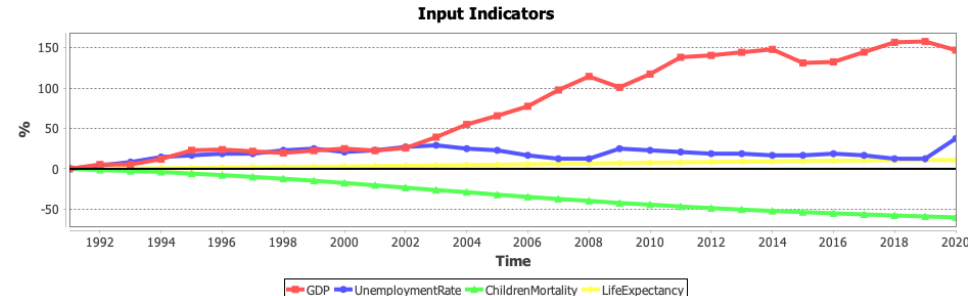
Figure 11. Input data trend for the time range 1991–2020 (Case Study 1).